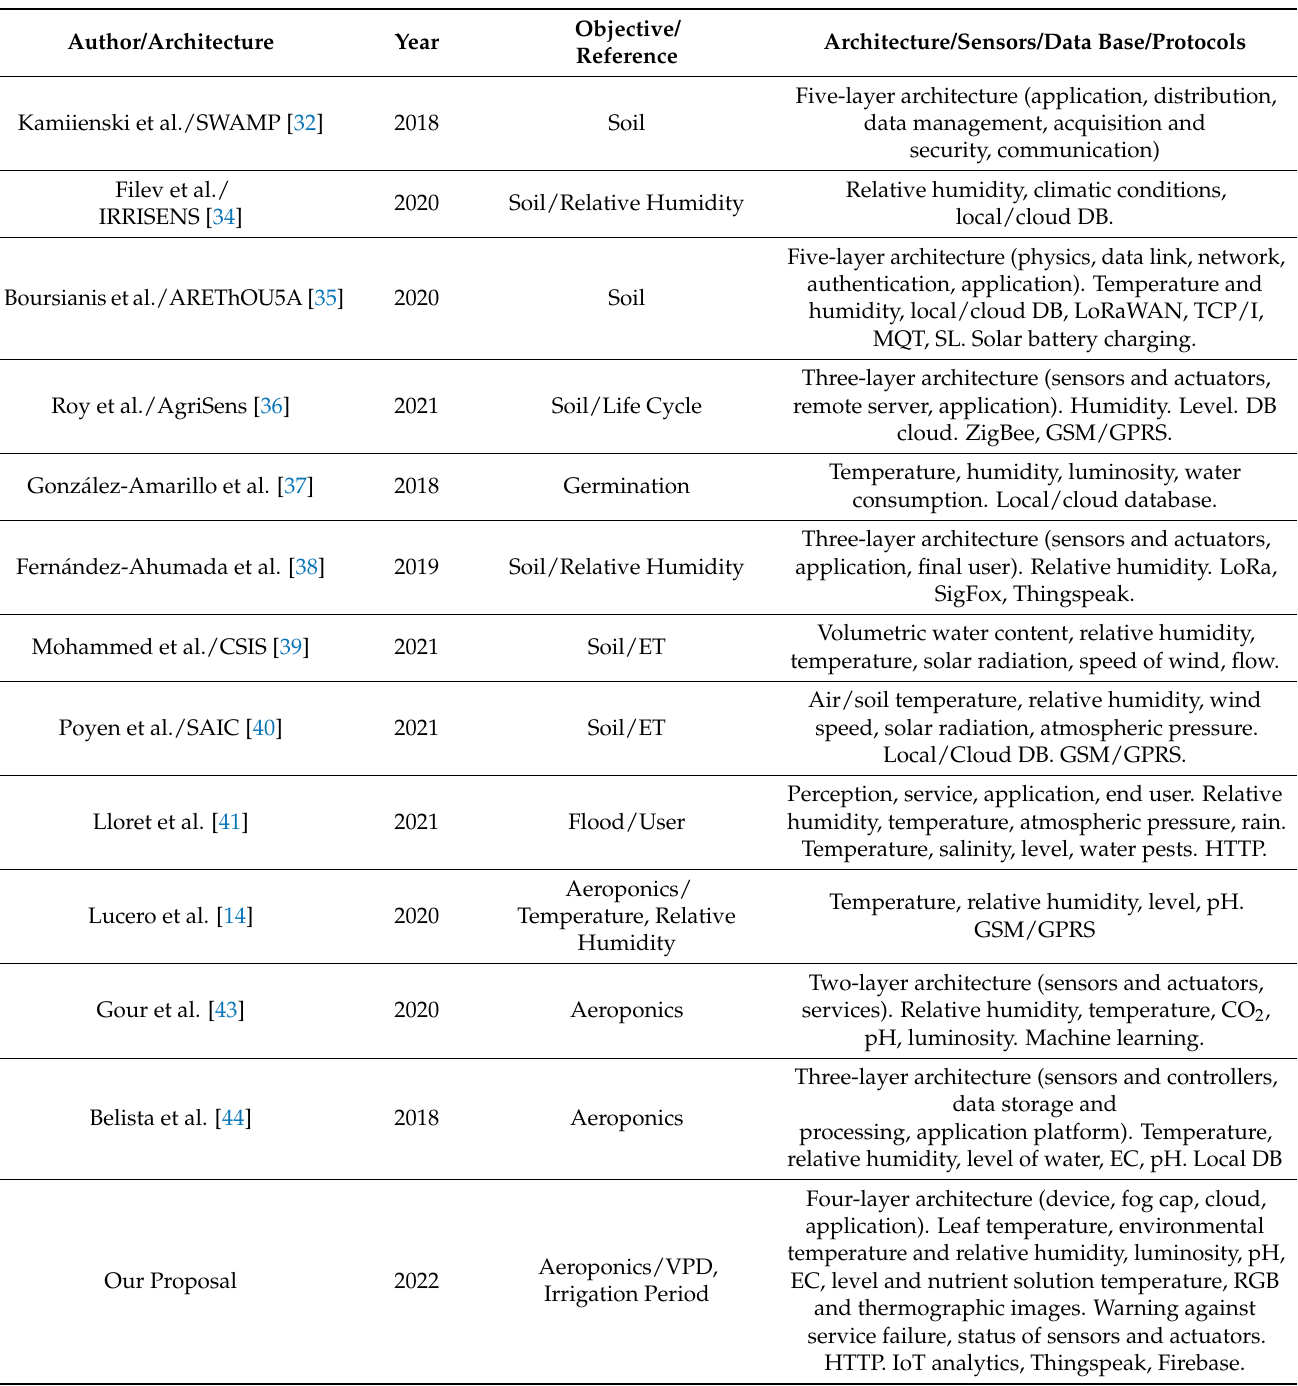
Table 2. Comparison considering elements included for monitoring, control and